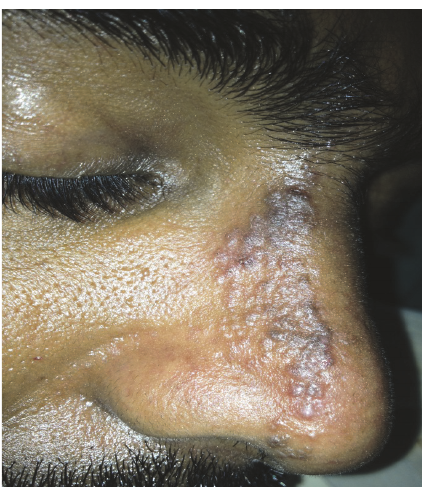
Figure 3: Three weeks after treatment with topical